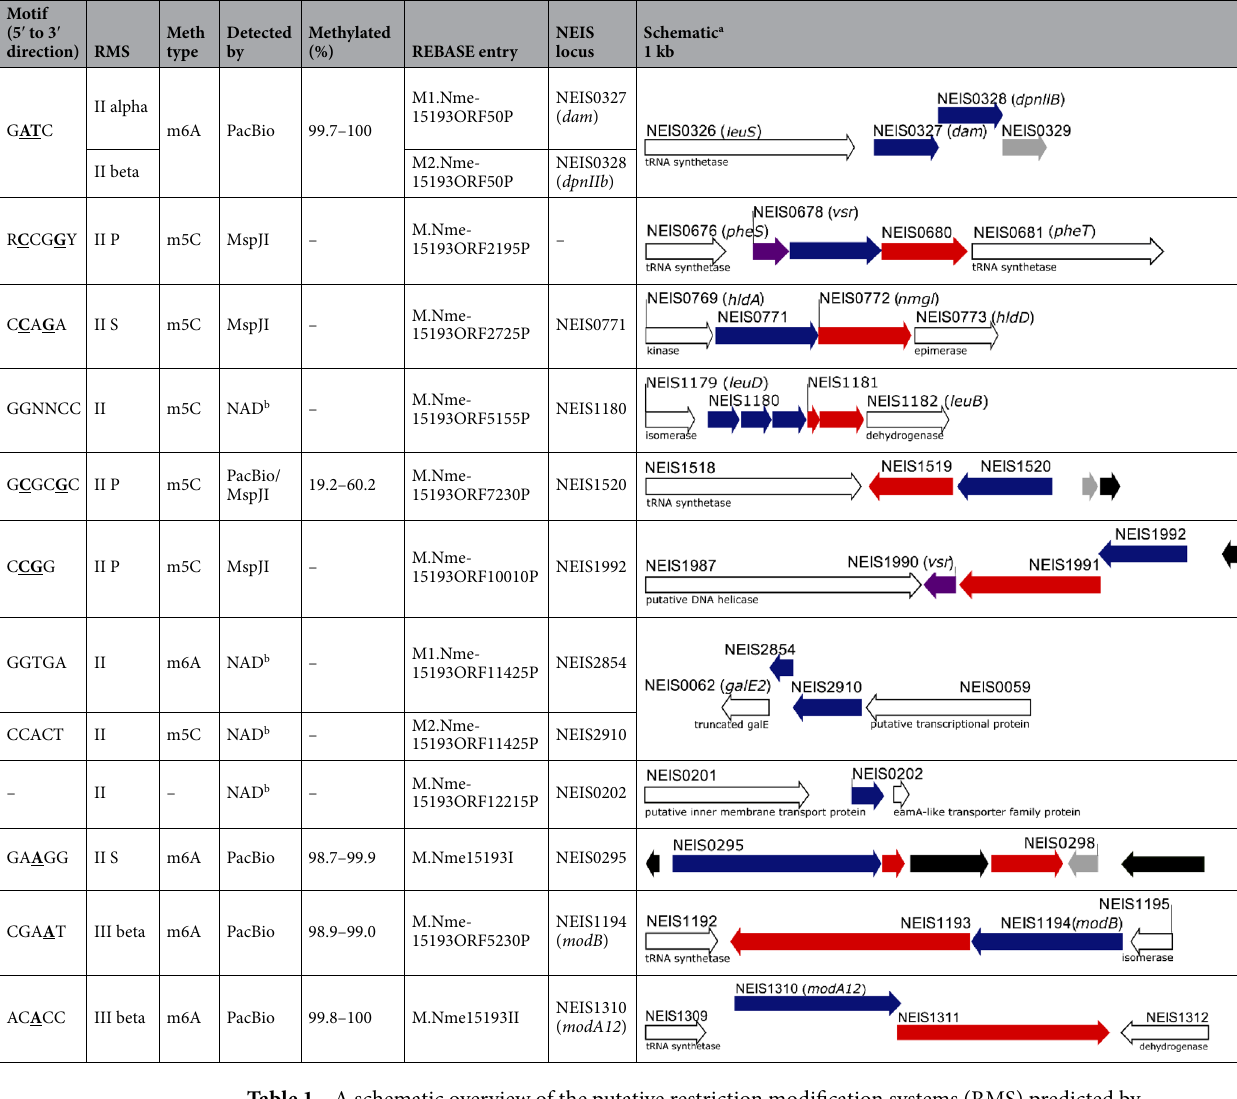
Table 1. A schematic overview of the putative restriction modification systems (RMS) predicted by SEQWARE in N. meningitidis serogroup W, isolate 15-193 used as a representative. a Methylases are shown in blue, restriction endonucleases in red, very short patch repair endonucleases in purple, transposase genes in black and hypothetical genes in grey. b No activity detected.